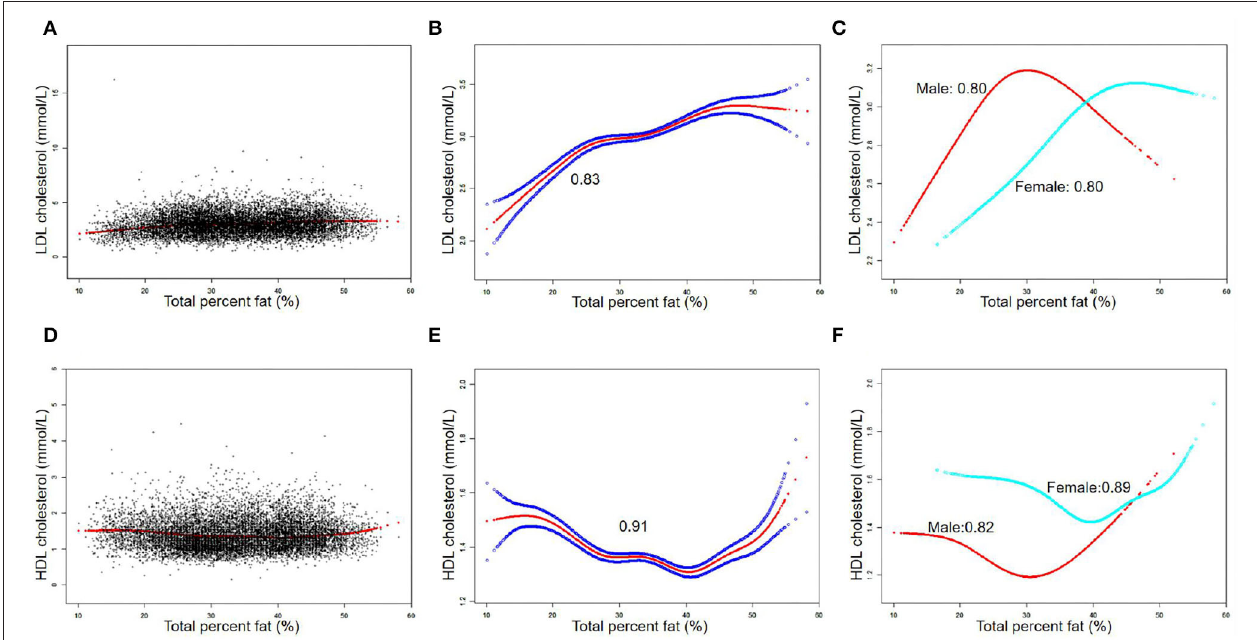
FIGURE 2 | The association between total percent fat (%) and low-density lipoprotein cholesterol (LDL-C), high-density lipoprotein cholesterol (HDL-C) (mmol/L). (A,D) Each black point represents a sample. (B,E) Solid red line represents the smooth curve fit between variables. Blue bands represent the 95% of confidence interval (CI) from the fit. (C,F) Stratified by sex. The correlation coefficients of (B,C,E,F) were described in the corresponding figures. Age, sex, race, BMI, hypertension, diabetes, smoking status, and vigorous work activity were adjusted [ (C) and (F) were not adjusted by sex].